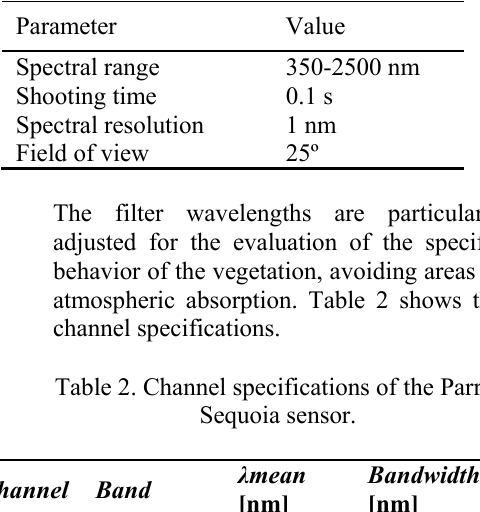
Table 1. Technical specifications of the Parrot Sequoia sensor.